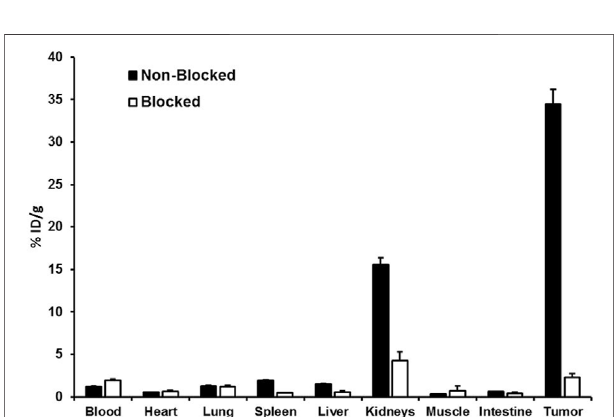
FIGURE 6 | Blockade experiment with 68 Ga-CA028 (0.05 nmol, 20 MBq) 1 h post injection. 2 mg of PSMA-617 per kilogram of body weight was injected at the same time as 68 Ga-CA028. Data are mean expressed ( n = 4).